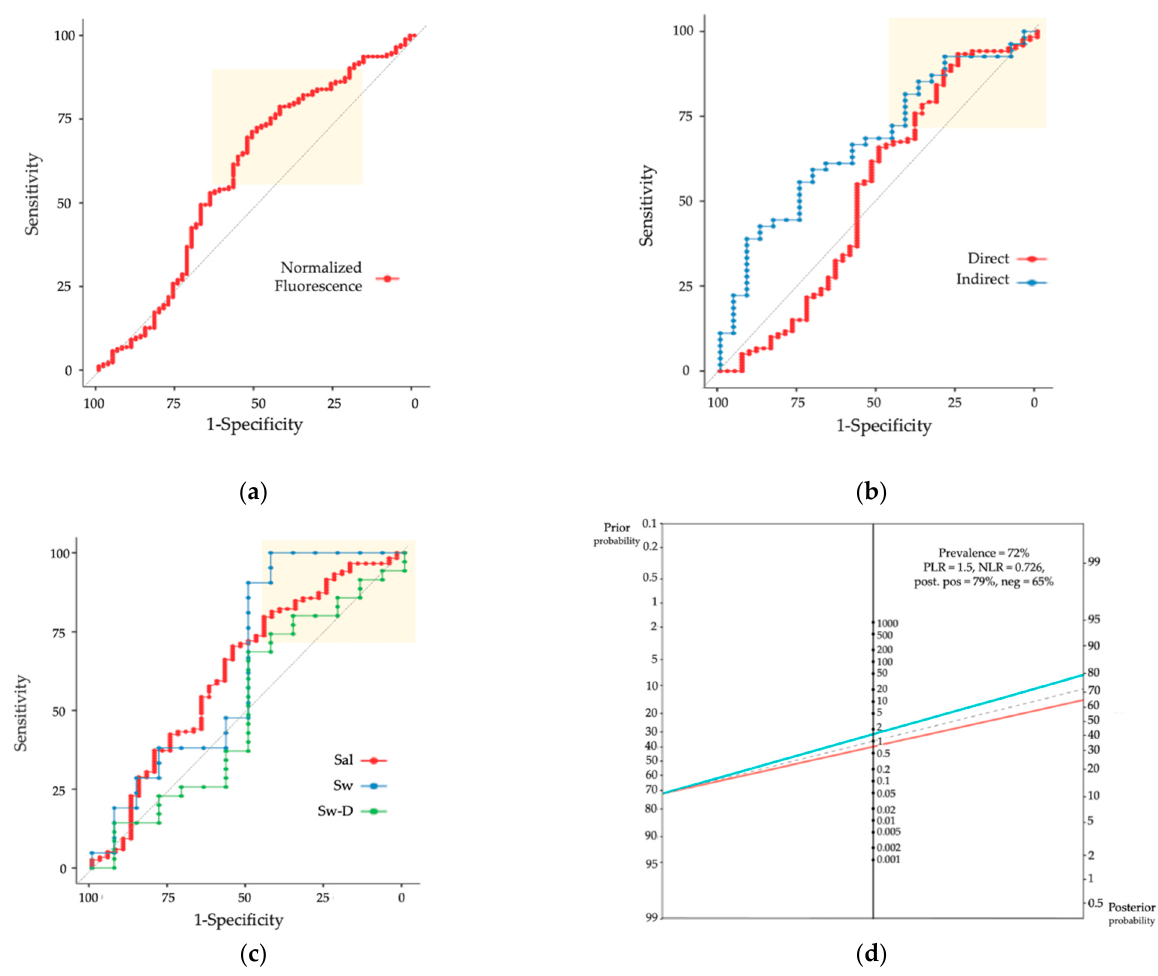
Figure 5. ROC curves for ( a ) overall samples; ( b ) protocol; and ( c ) sample type. ( d ) Fagan nomogram for post ‐ test probability of positive (red line) and negative outcomes (blue line). Yellow squares delimit cutoff zones with high sensibility and specificity.